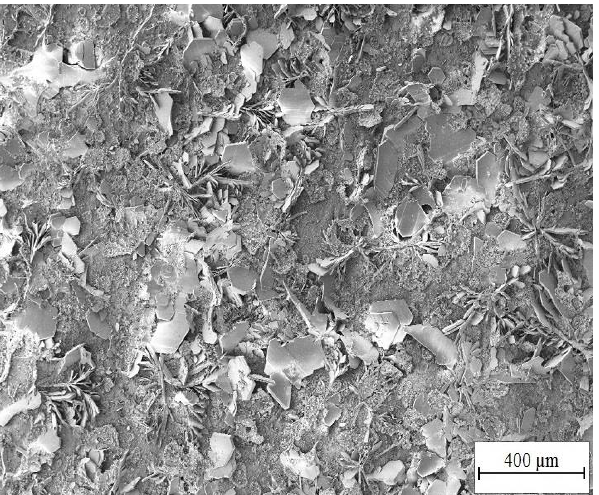
Figure 20. Morphology of precipitated corrosion products on the surface of HDG sample after exposure (3 months) in simulated concrete pore solution of pH 12.8 with addition of KMnO 4 − (solution Mn (2) ).